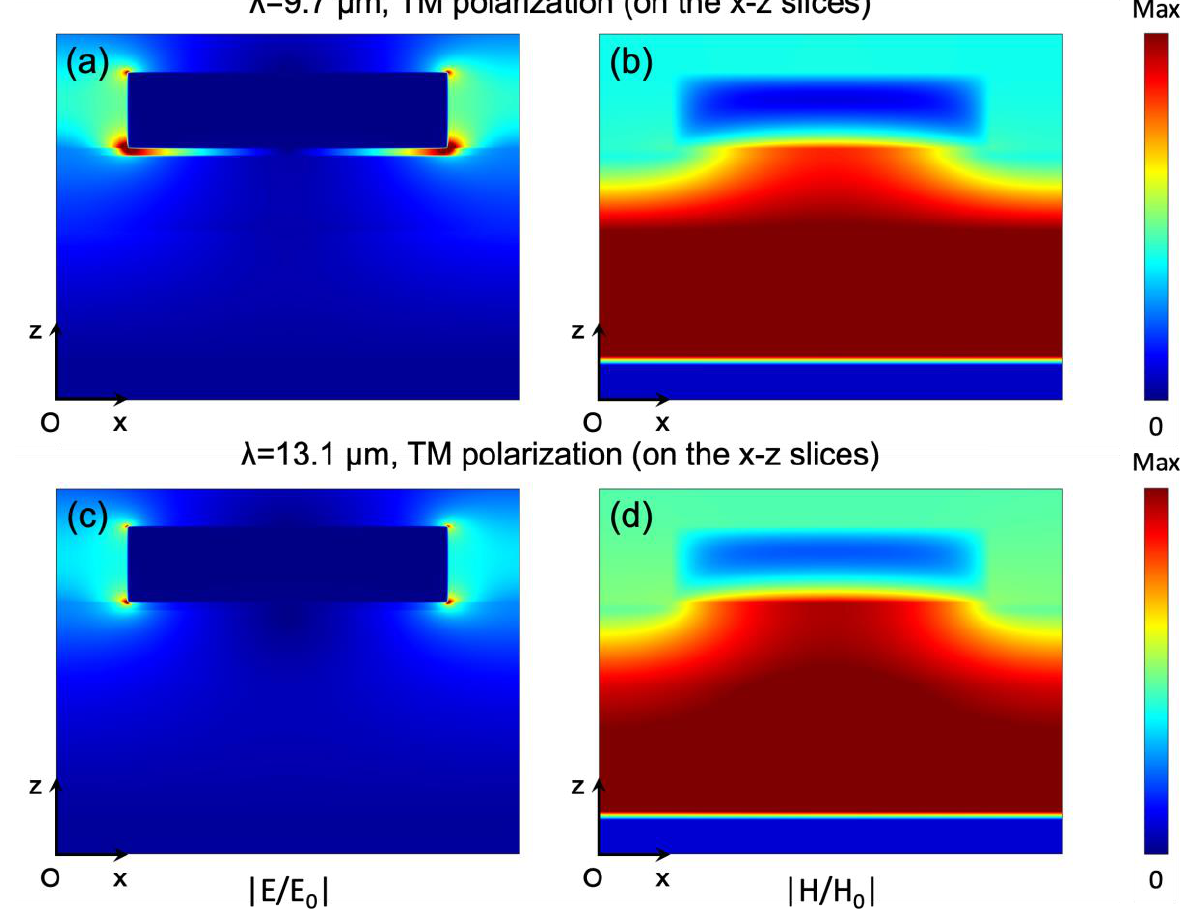
Figure 8. ( a ) Electric field and ( b ) magnetic field distribution at absorption peak at 9.7 µ m under TM-polarized light; ( c ) electric field and ( d ) magnetic field distribution at absorption peak at 13.1 under TM-polarized light.